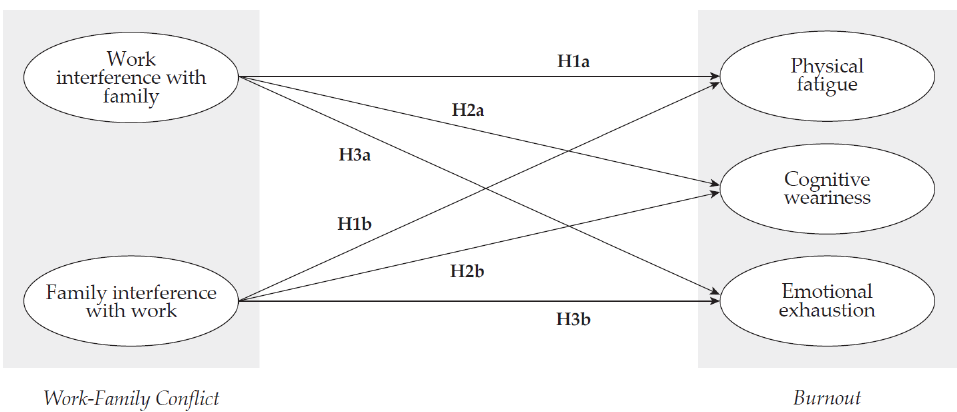
Figure 1. Research model.